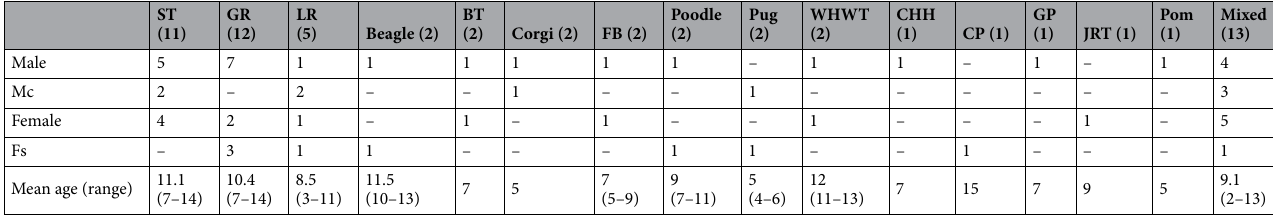
Table 1. Demographics of 60 diffuse large B-cell lymphoma dogs in this study. BT Bull terrier, CHH Chihuahua, CP Cocker spaniel, FB French bulldog, Fs sprayed female, GP German shepherd, GR Golden retriever, JRT Jack Russel terrier, LR Labrador retriever, Mc castrated male, Pom Pomeranian, ST Shih Tzu, WHWT West highland white